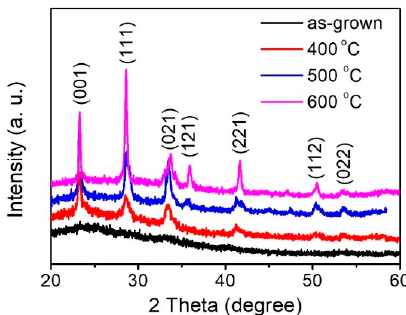
Figure 1. XRD patterns of the WO 3 films with and without thermal annealing procedures.